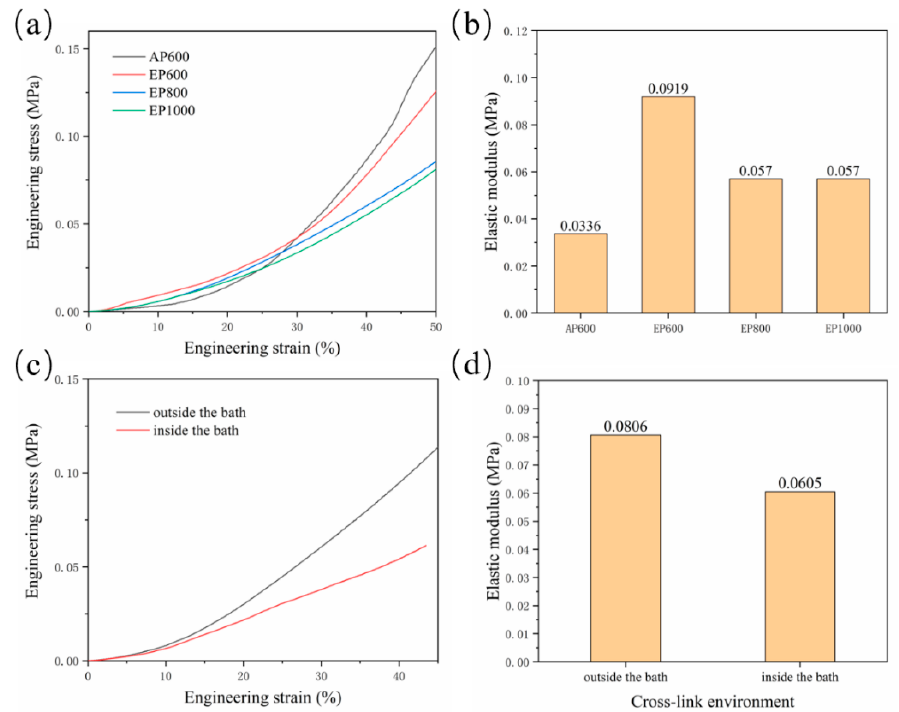
Figure 6. ( a ) Stress–strain curve of AP600, EP600, EP800, EP1000; ( b ) elastic modulus of the scaffolds; ( c ) stress–strain curve of EP600 in different cross-linking sites; ( d ) elasticity of the corresponding scaffold modulus.